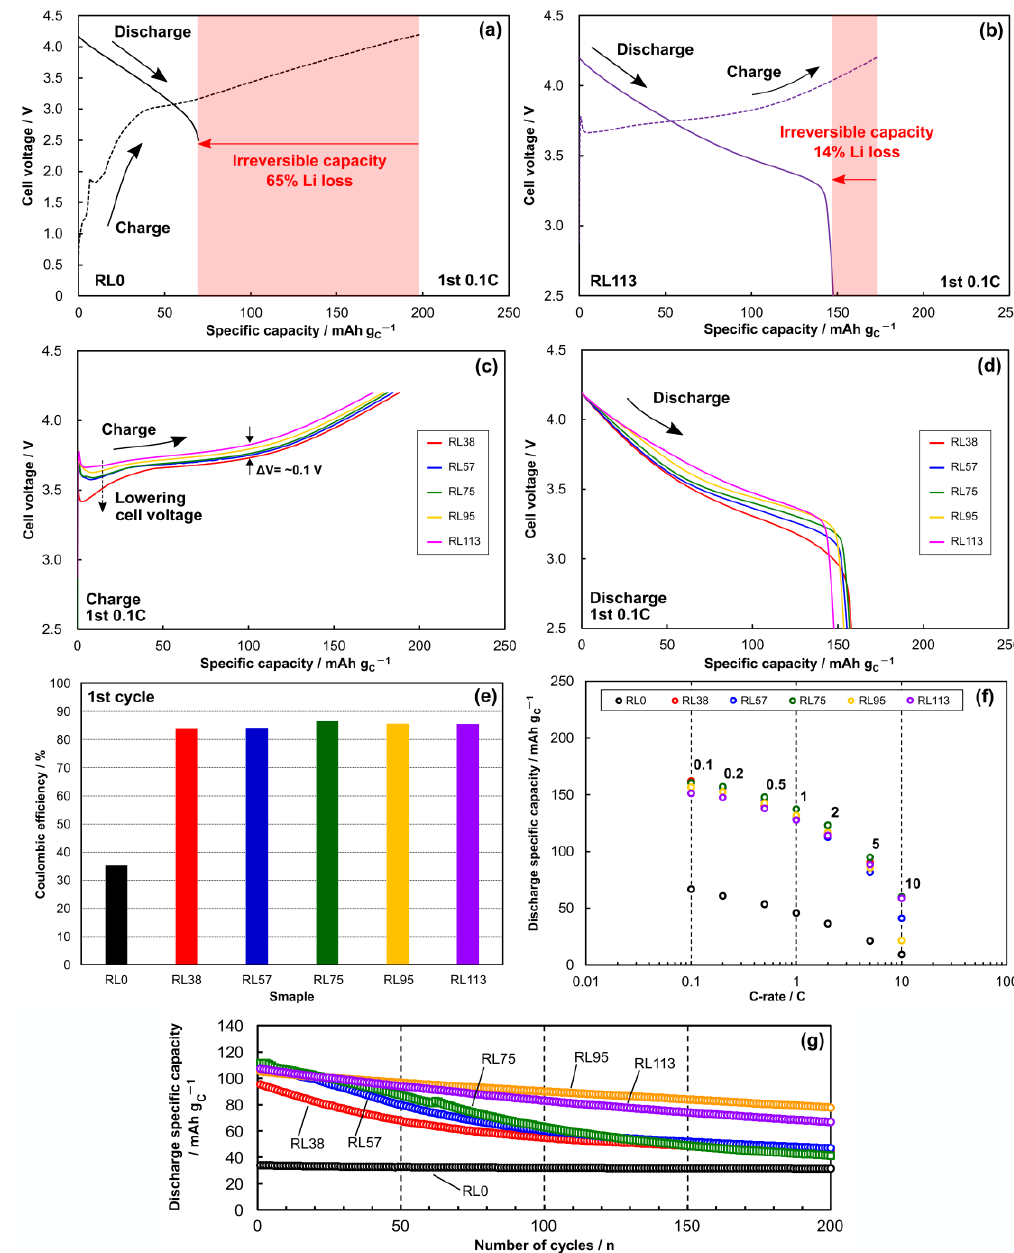
Figure 5. Full-cell performance of the NCM523|HC8/N-Si2 cells with different R L values: ( a , b ) first- cycle cell voltage curves of ( a ) RL0 and ( b ) RL113; ( c , d ) a comparison of first-cycle profile for ( c ) charge and ( d ) discharge, and ( e ) the corresponding CEs; ( f ) rate and ( g ) cycling performance of the NCM523|HC8/N-Si2 cells.